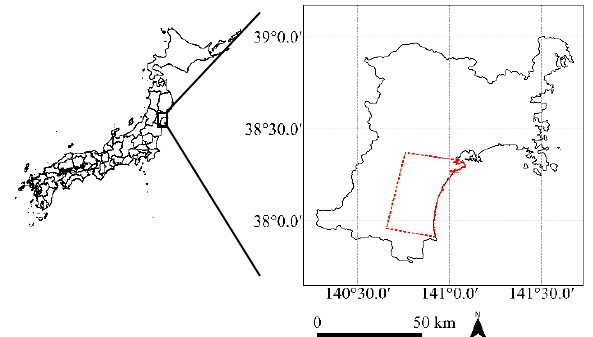
Figure 1. Location of study area; The red dotted line shows the area for land cover classification.